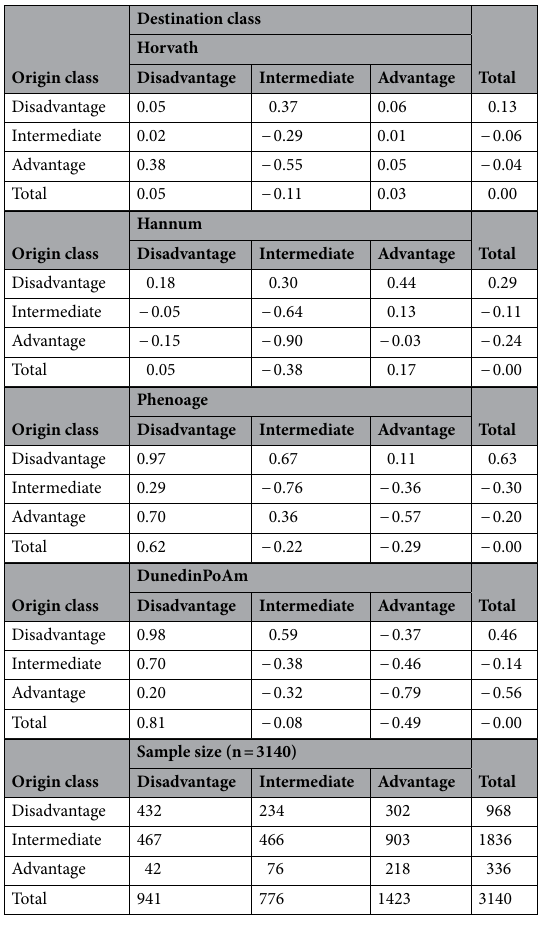
Table 2. Arithmetic mean of age acceleration indexed by Horvath, Hannum, Phenoage and DunedinPoAm algorithm, by origin (childhood) and destination (adulthood) social class, sample size of each cell is given at the bottom of the table. UK Household Longitudinal Study,